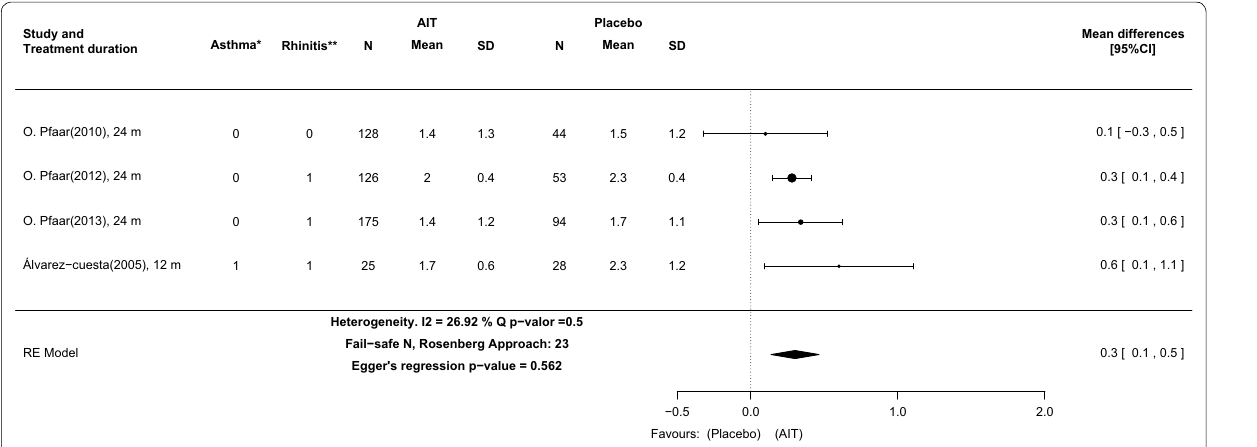
Fig. 6 DPAEs versus placebo in all pollen seasons of original studies. Outcome: health‑related quality of life (HRQL) measured with Rhinoconjunctivitis Quality of Life Questionnaire (RQLQ). *Asthma classification: (0) Only intermittent asthma patients included; (1) Intermittent to mild persistent asthma patients included; (2) Intermittent to moderate persistent asthma patients included. **Rhinoconjunctivitis classification: (0) Any rhinoconjunctivitis severity included; (1) Moderate to severe rhinoconjunctivitis included. 95%CI: 95% confidence interval; m months, SD standard